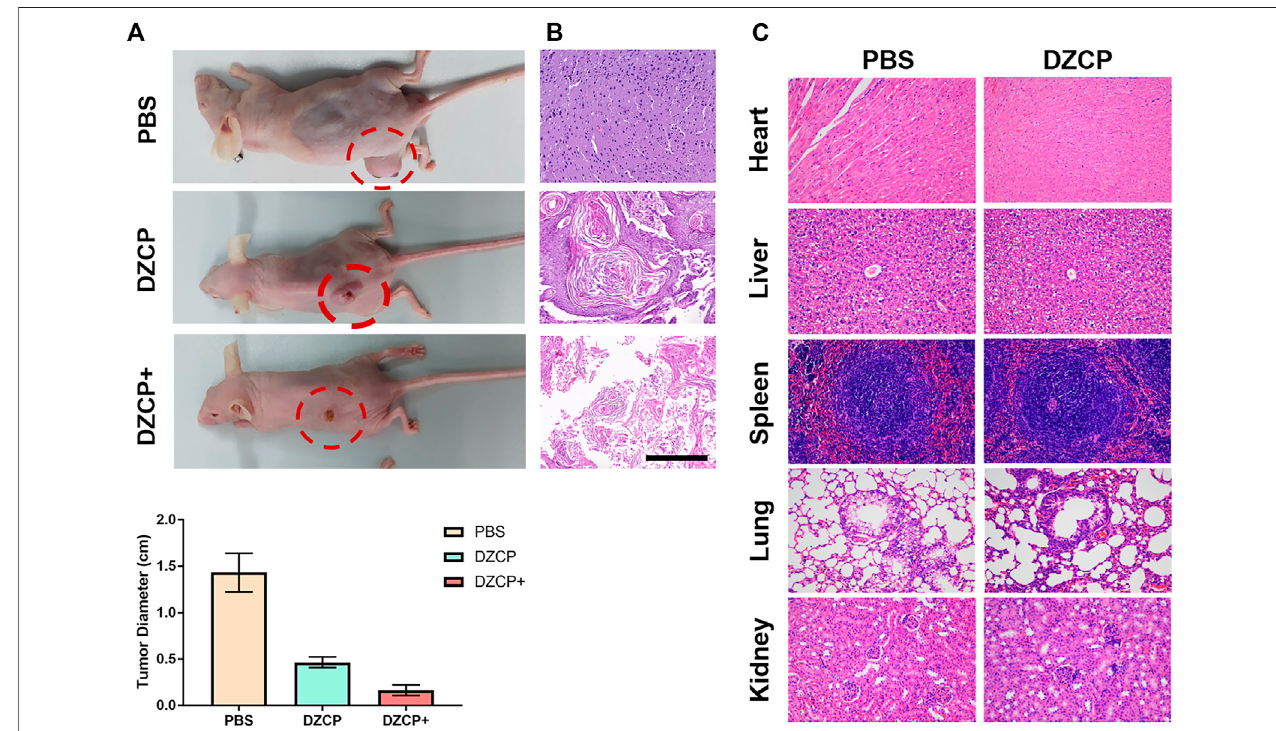
FIGURE 4 | (A) Photos of 4T1 tumor-bearing mice at the end of treatments. Comparison of the PBS, DZCP, and DZCP groups. Histological images of (B) tumor sections and (C) different tissue sections after treatment. Scale bar is 50 μ